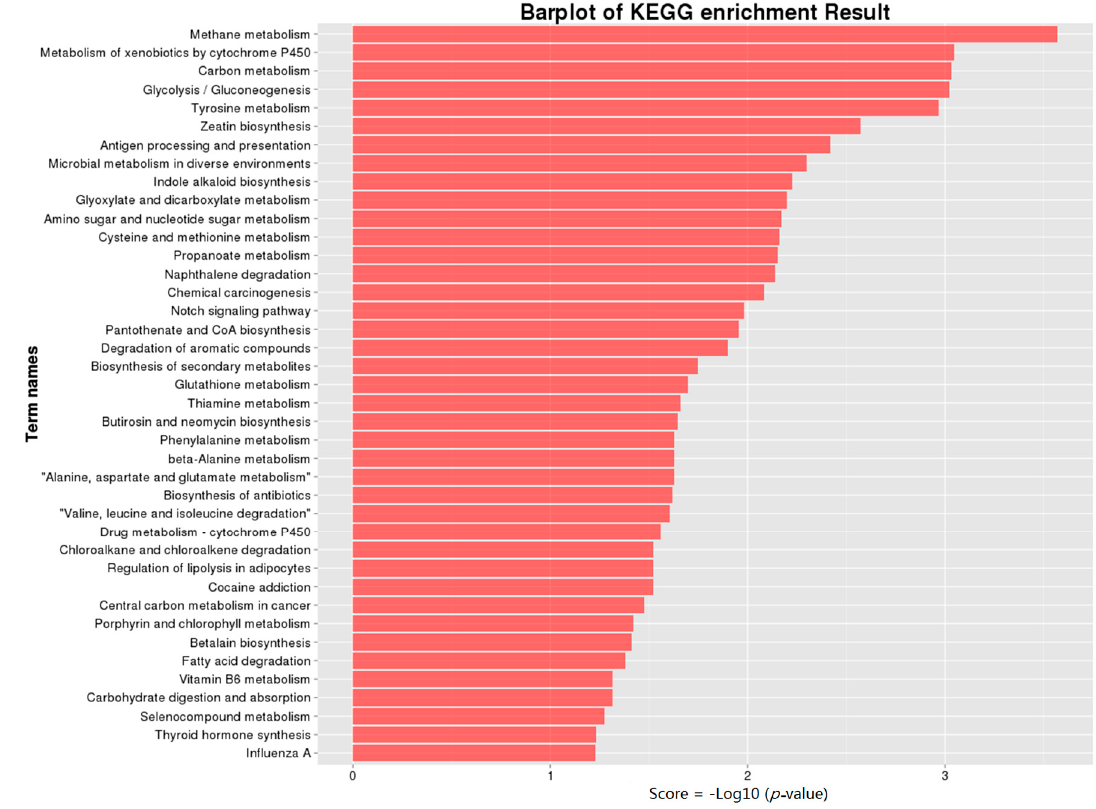
Figure 4. KEGG annotation of differentially expressed genes. 78 DEGs were subjected to KEGG annotation and were grouped into 37 pathway classes. The vertical axis shows the name of KEGG terms and the horizontal axis displays the − Log10 ( p -value). A p -value < 0.05 was used as a threshold to select significant KEGG pathways.